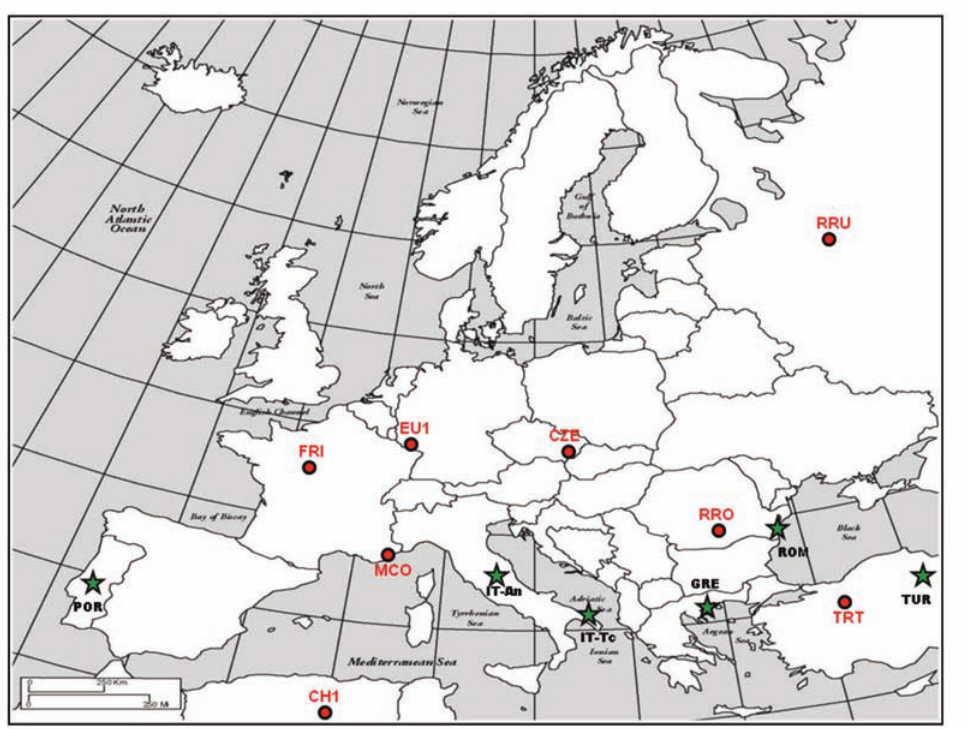
Figure 1. Map showing the locations of the receivers and the LF transmitters of the European Radio Network. Stars, receivers; circles, LF transmitters, the signals of which were collected by the different receivers. Some particularities of these transmitters are reported in Table 1. Code